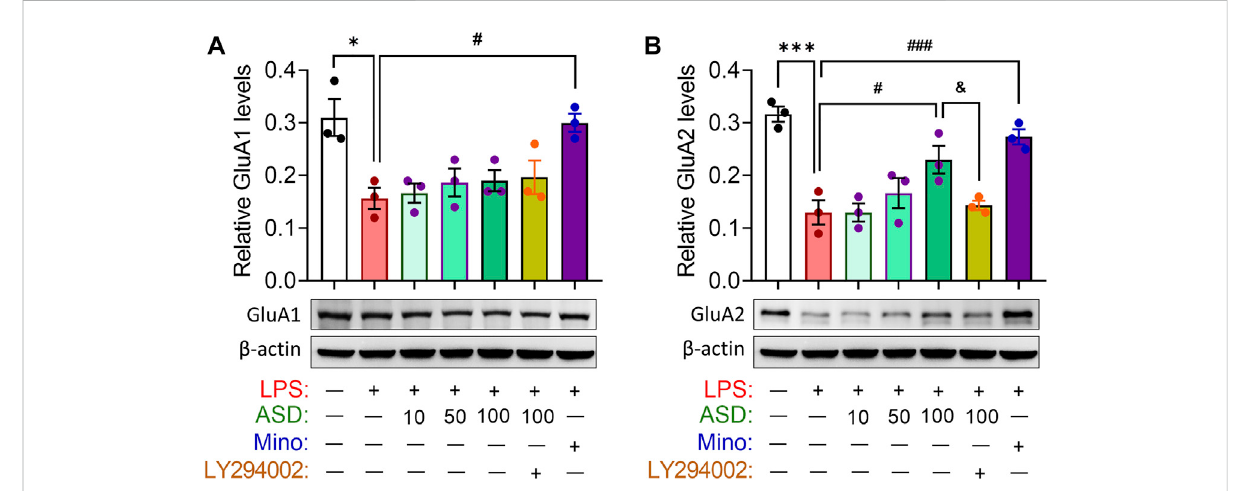
FIGURE 6 Effects of ASD on synaptic function in hippocampus of mice chronically exposed to LPS. (A,B) , Western blotting shows the levels of GluA1 and GluA2 in the hippocampus of mice treated with saline (Ctrl) or lipopolysaccharide (LPS), then with akebia saponin D (ASD), minocycline (Mino) or PI3K-Akt inhibitor(LY294002).LevelsofGluA1andGluA2werenormalizedtothoseof β -actin.Figures6A,Bsharethesame β -actin.Dataaremean± standard error of the mean (SEM) (n = 4), * p < 0.05, *** p < 0.001 vs. Ctrl group, # p < 0.05, ### p < 0.001 vs. LPS group, & p < 0.05 vs. ASD (100 mg/kg) + LPS group based on one-way ANOVA with Tukey ’ s multiple-comparisons